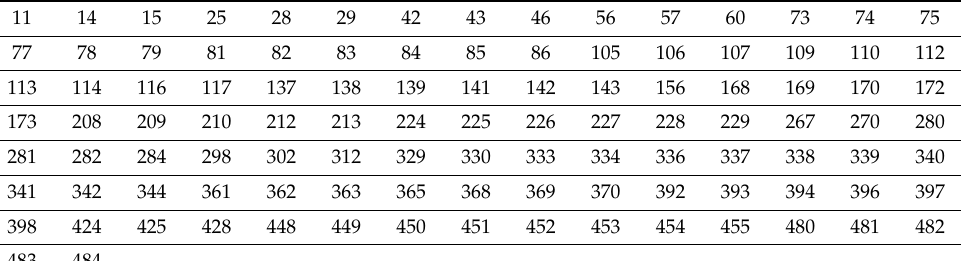
Table 4. x3 corresponding to block P texture template (decimal).